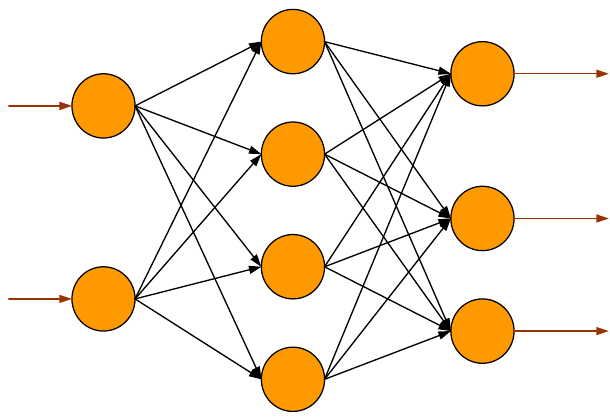
Figure 3: Multilayer feedforward neural network model.